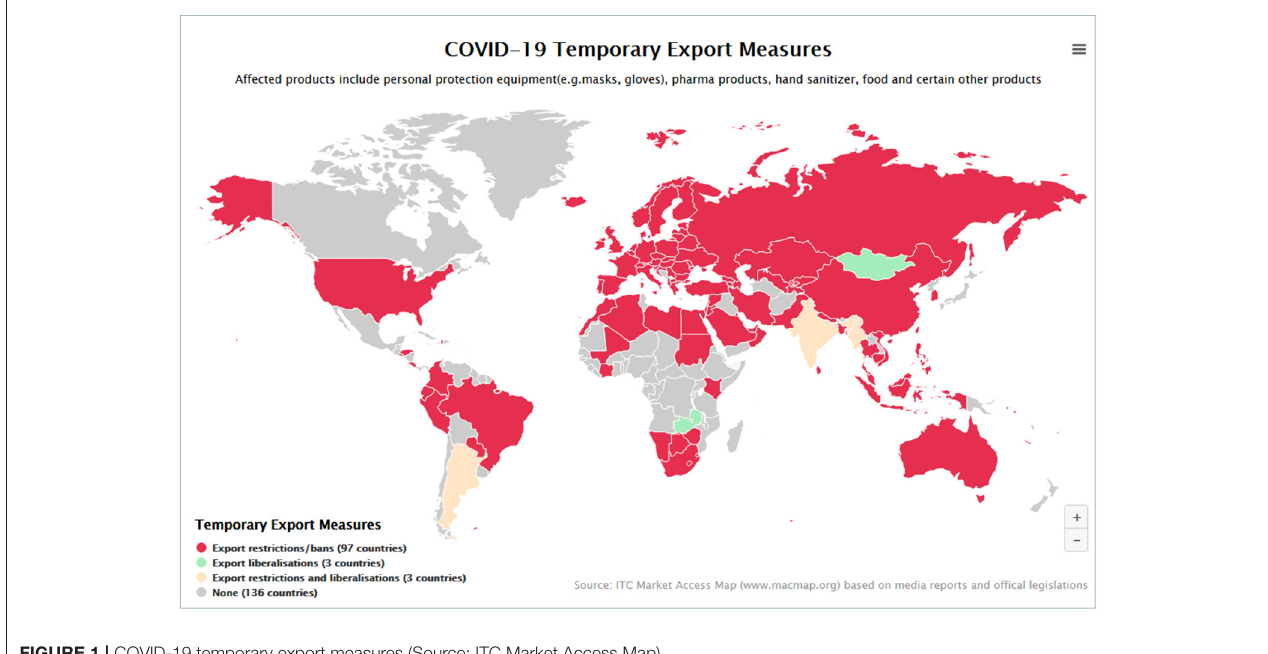
FIGURE 1 | COVID-19 temporary export measures (Source: ITC Market Access Map).